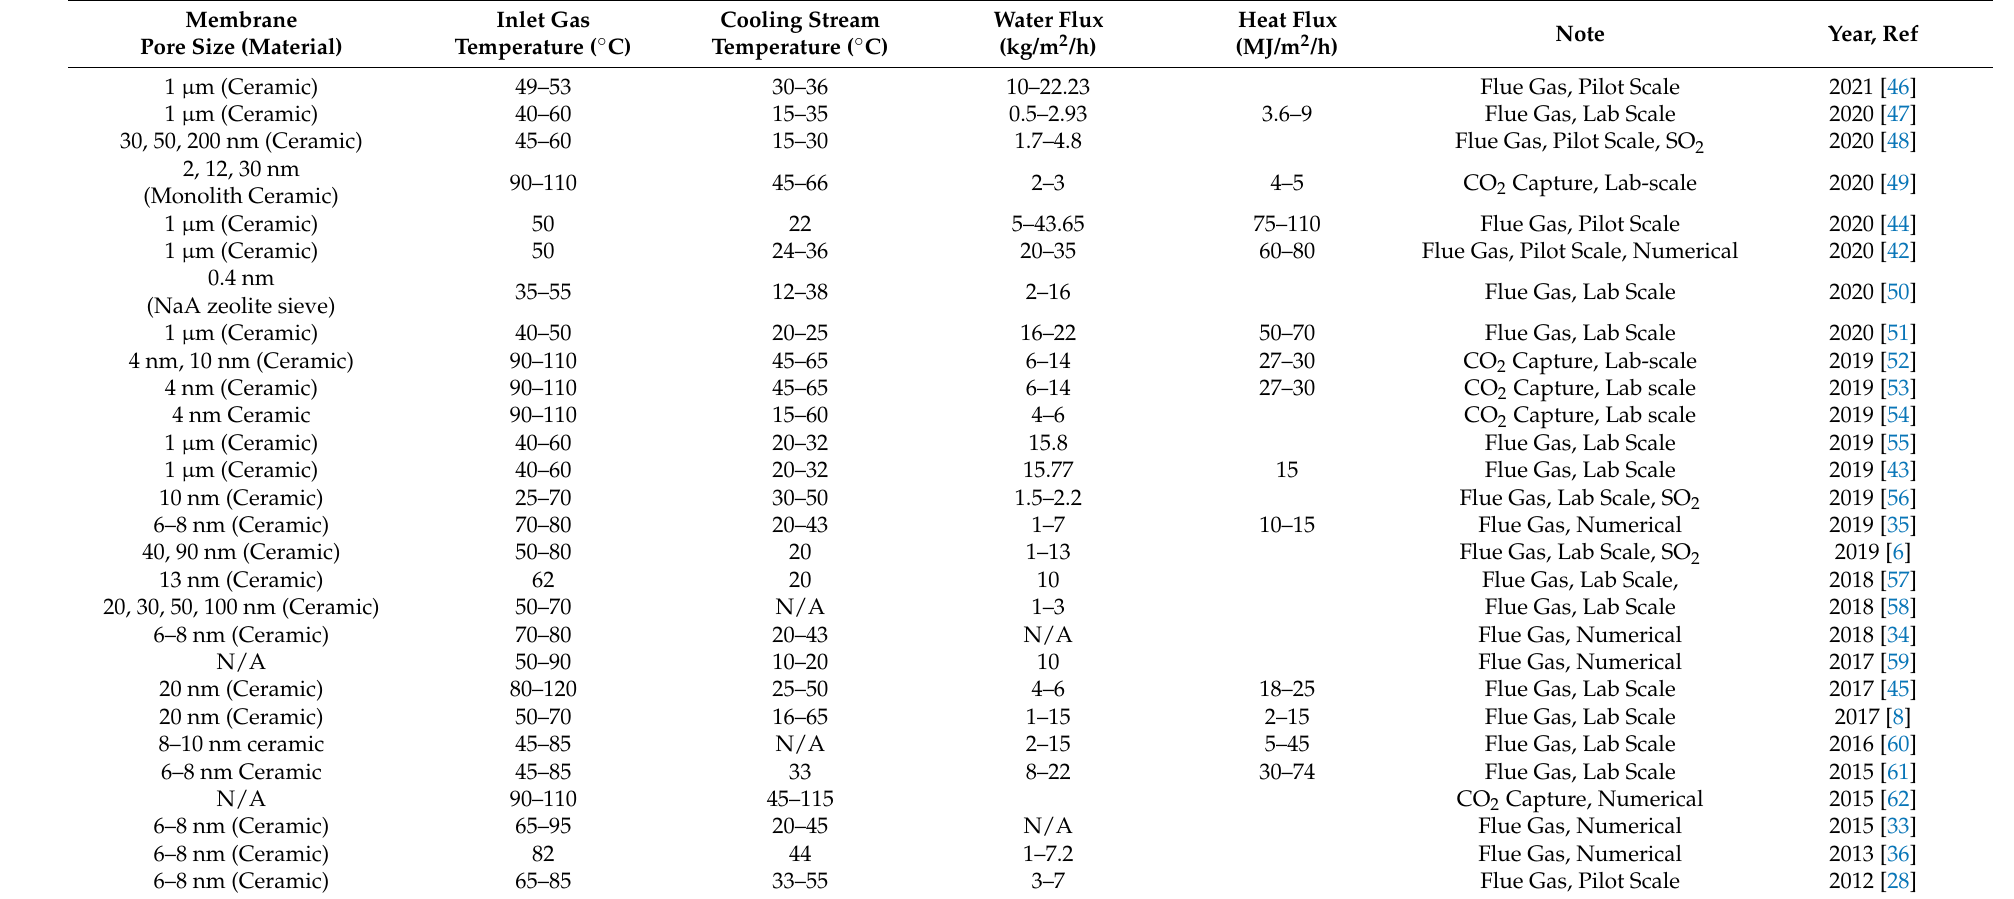
Table 2. Summary of literature data on the TMC process.